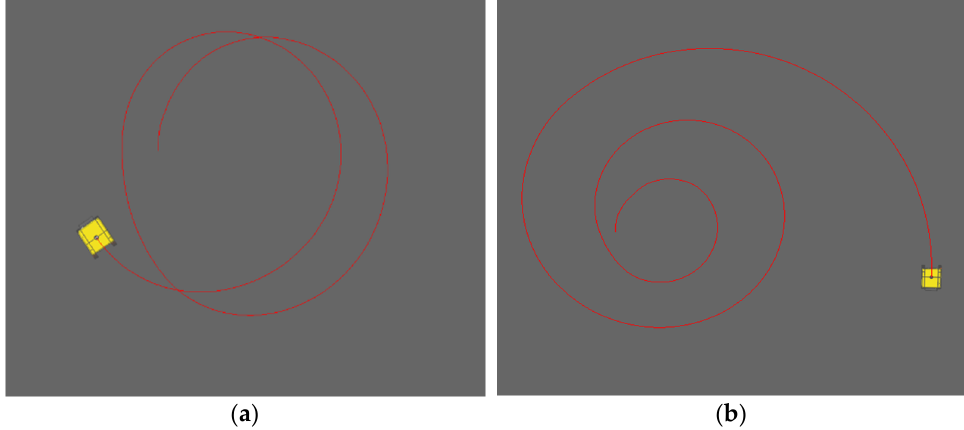
Figure 10. Trajectory diagram of simulation model of DSLV. ( a ) Trajectory under constant driving force; ( b ) Trajectory under variable driving force.